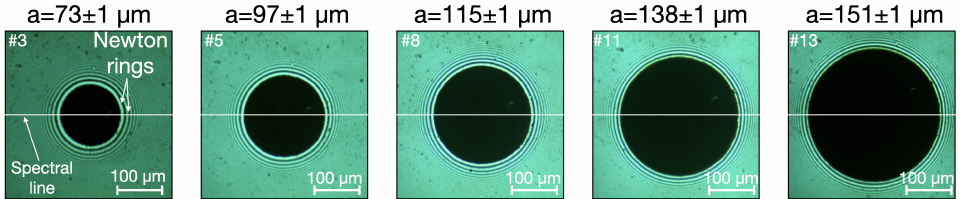
Figure 5. Images of the contact: Images from the microscope are displayed with a scale of 100 µm in presentation software. A circle with a thickness of 0.75 pt to measure the diameter of the contact disc is drawn without filling. Given our scale of 100 µm or 85.32 pt, the thickness of the circle is 0.88 µm. Since the diameter is measured from edge to edge of the circle, the uncertainty in the diameter measurement is twice the thickness of the circle line, i.e., 1.76 µm. Consequently, the uncertainty in determining the radius is divided by two, i.e., 0.88 µm. Finally, this value is rounded to 1 µm to be used as the uncertainty of the